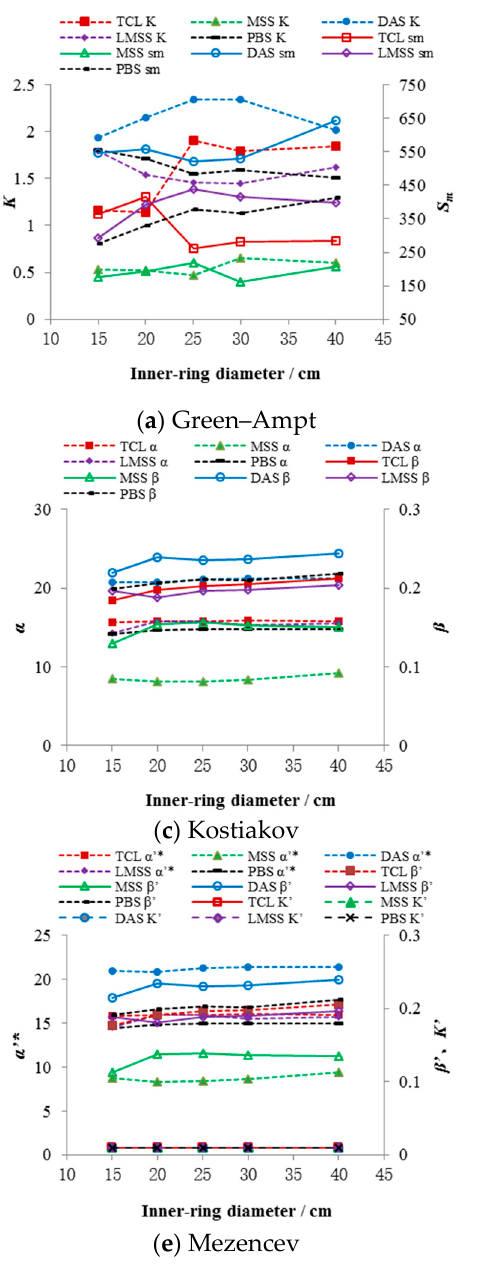
Figure 4. Model parameters of the six infiltration models with five kinds of infiltrometer diameters for five soil types in Xilin River Basin (TCL, MSS, DAS, LMSS, PBS represent thick chestnut loess, meadow swamp soil, desert aeolian soil, limy meadow sandy soil, and pale black soil, respectively).